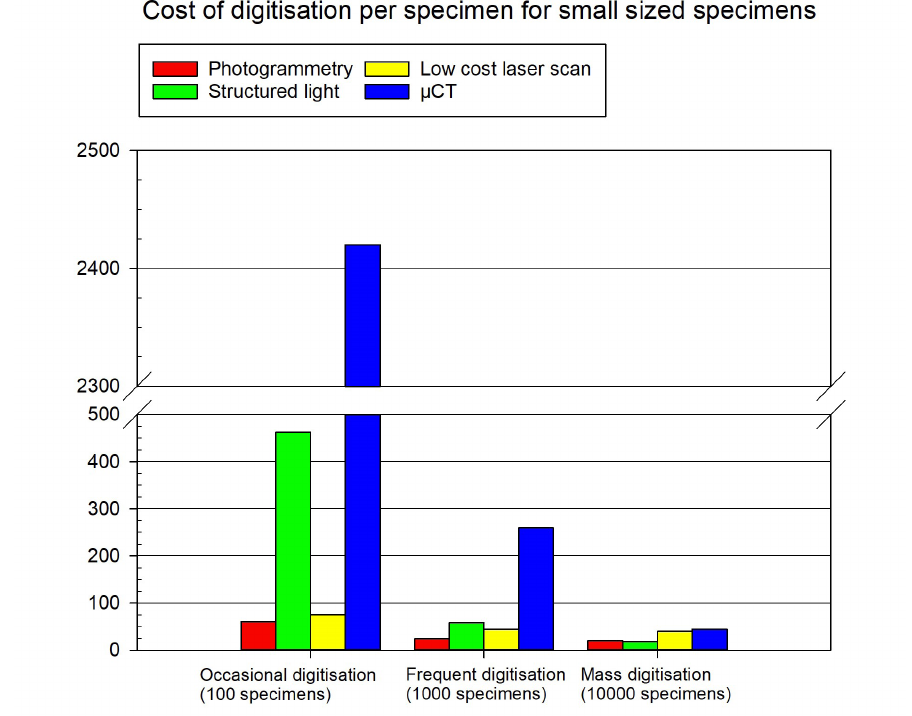
Fig. 6.13. Cost/efficiency ratio of digitisation for small-sized